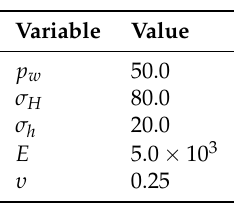
Figure 16. Bradley’s 2-D geometry, BCS, and a sample mesh. Table 4. Parameters for Bradley’s